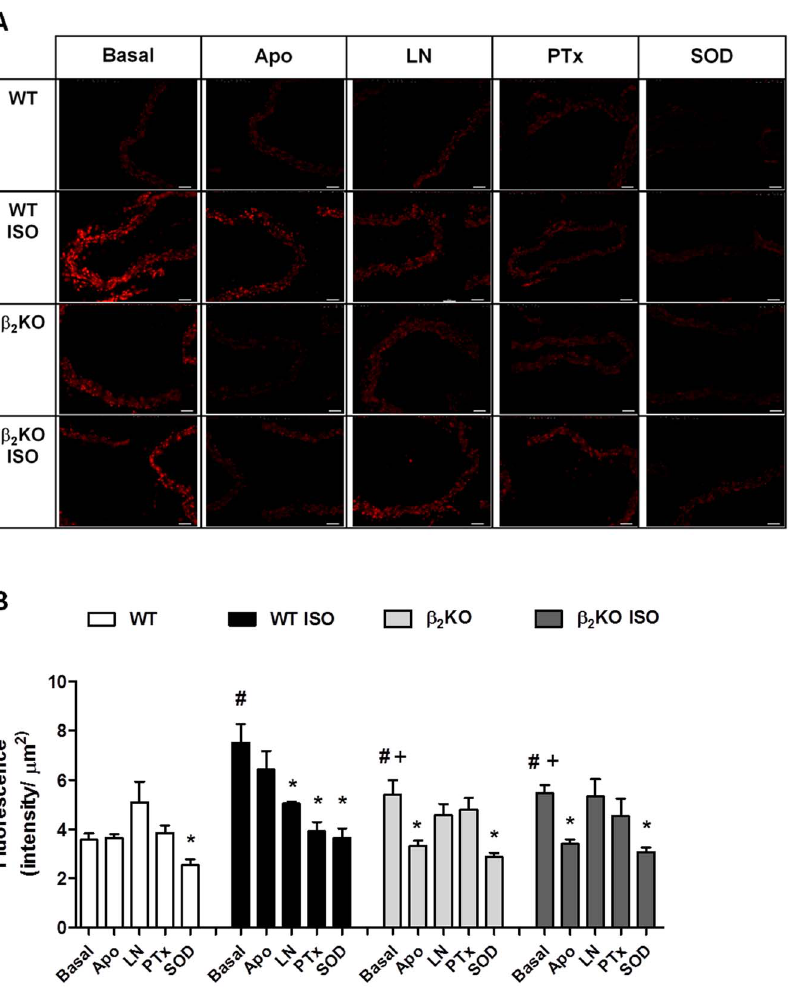
Figure 6. Gi a protein activity mediates the vascular oxidative stress induced by isoproterenol. Panel A shows representative fluorographs of microscopic sections of thoracic aorta from wild-type (WT) and b 2 KO mice treated for 7 days with vehicle or isoproterenol (ISO). Vessels were labeled with the oxidative dye hydroethidine, which produces a red fluorescence when oxidized to ethidium bromide. Panel B shows the densitometric analysis of the ethidium-bromide-positive nuclei evaluated under basal conditions or incubated with apocynin (APO, 30 m M), L- NAME (LN, 100 m M), PTx (4 m M) or superoxide dismutase (SOD, 150 U/mL). The fluorescence signal was evaluated as the intensity of fluorescence per pixel normalized by vessel area. Values are presented as the mean 6 SEM. N=4–7 animals in each group. Significance was assessed using a 2-way ANOVA: *p , 0.05 vs . respective basal values for each group; # p , 0.05 vs . basal WT value; + p , 0.05 vs . ISO-treated WT value.